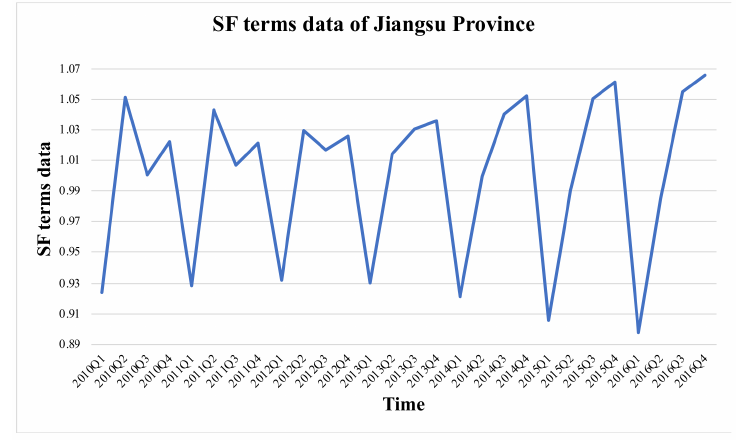
Figure 12. SF terms data of Jiangsu Province.